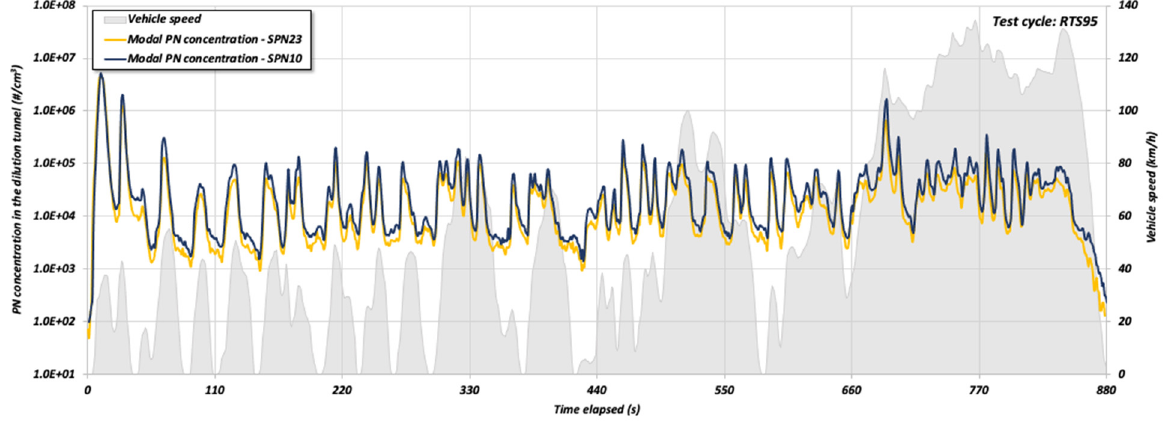
Figure 3. Comparison between SPN23 and SPN10 emissions over the RTS95.